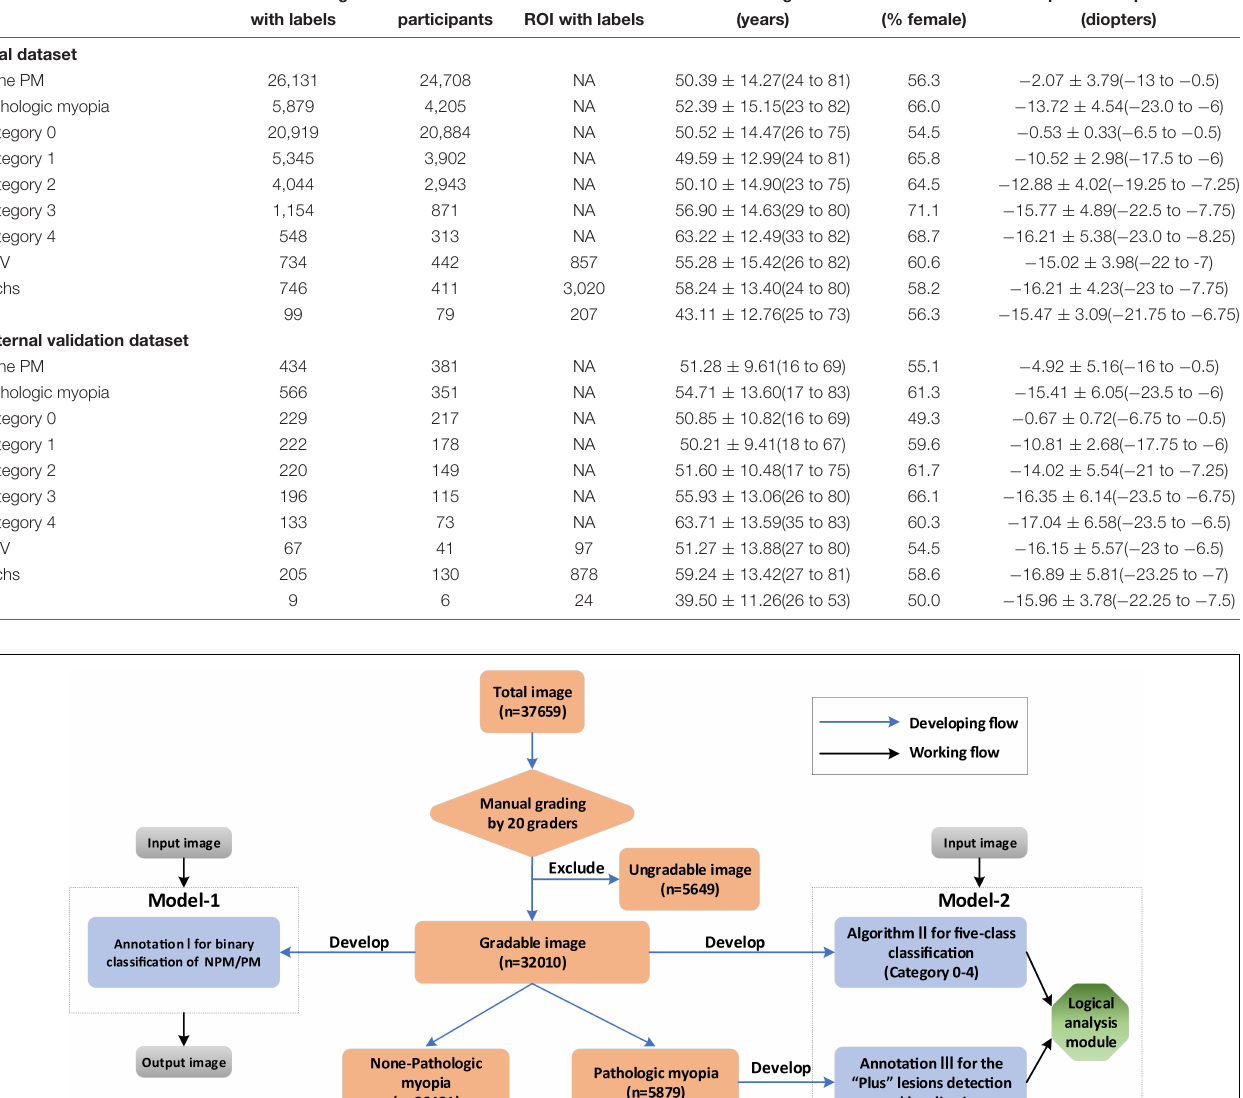
TABLE 1 | Summary of the total dataset and external validation dataset.